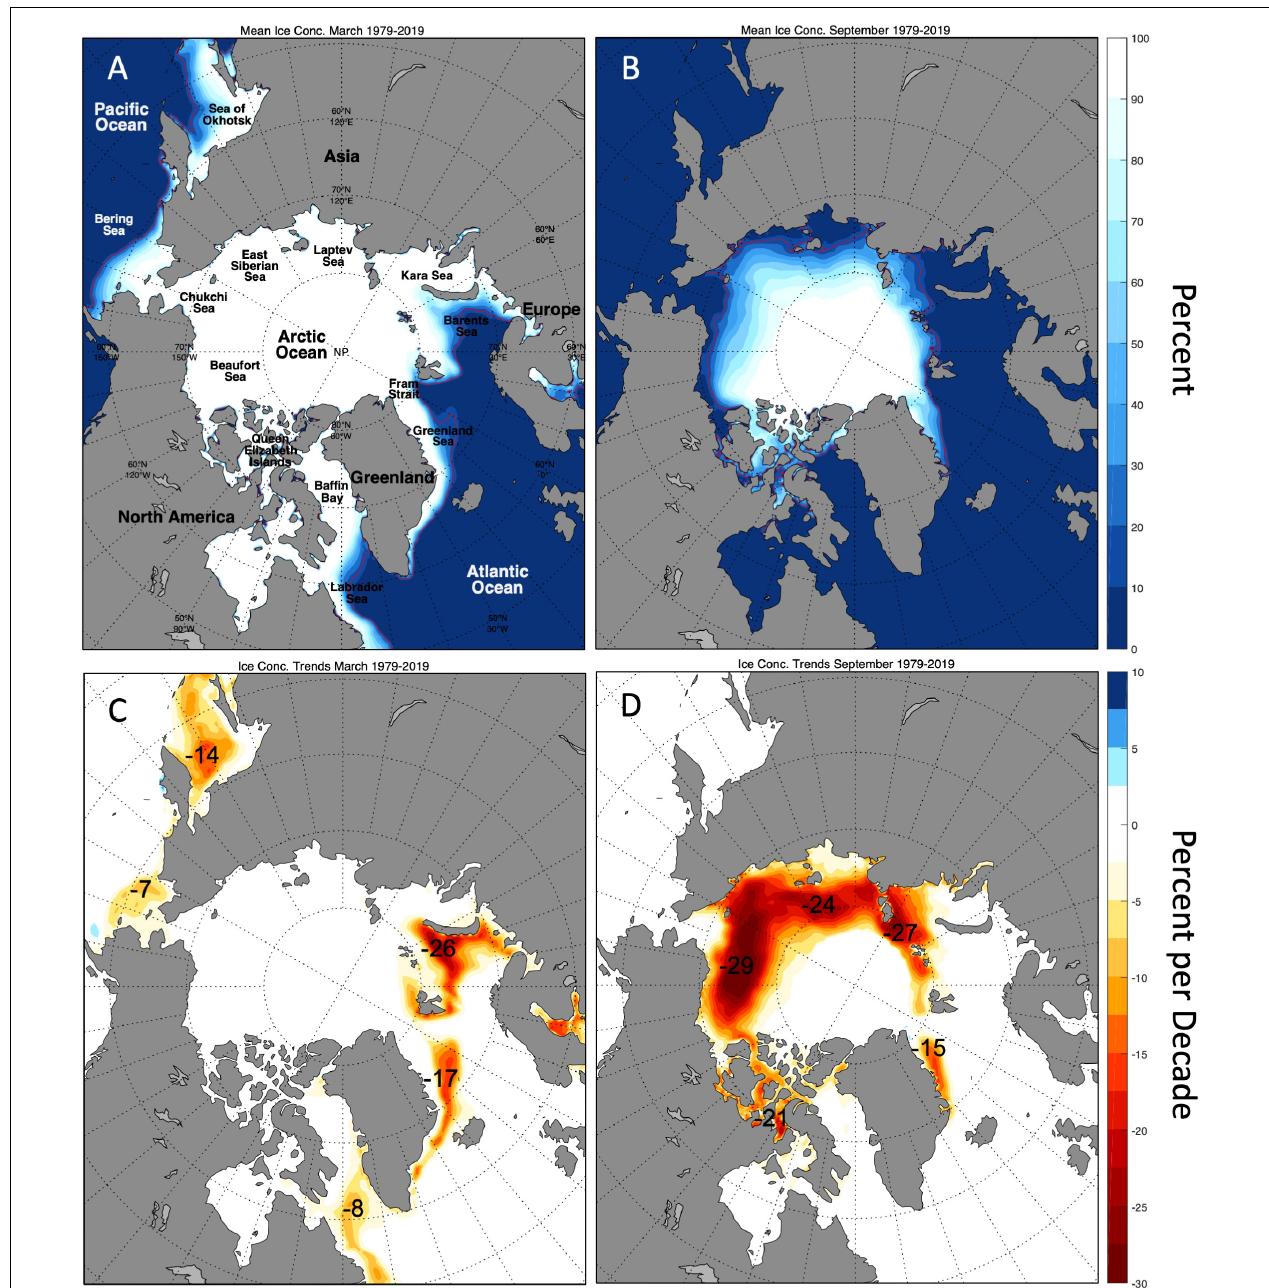
FIGURE 6 | Arctic Mean Sea Ice Concentration (percent) during the last 4 decades (1979–2019) in winter (March; A ) and summer (September; B ); and Arctic Sea Ice Concentration Trends (percent per decade) in winter (March; C ) and summer (September; D ) during the same 40 year period (1979–2019) estimated from Bootstrap Sea Ice Concentration analysis (https://nsidc.org/data/nsidc-0079/versions/3; Comiso, 2017).